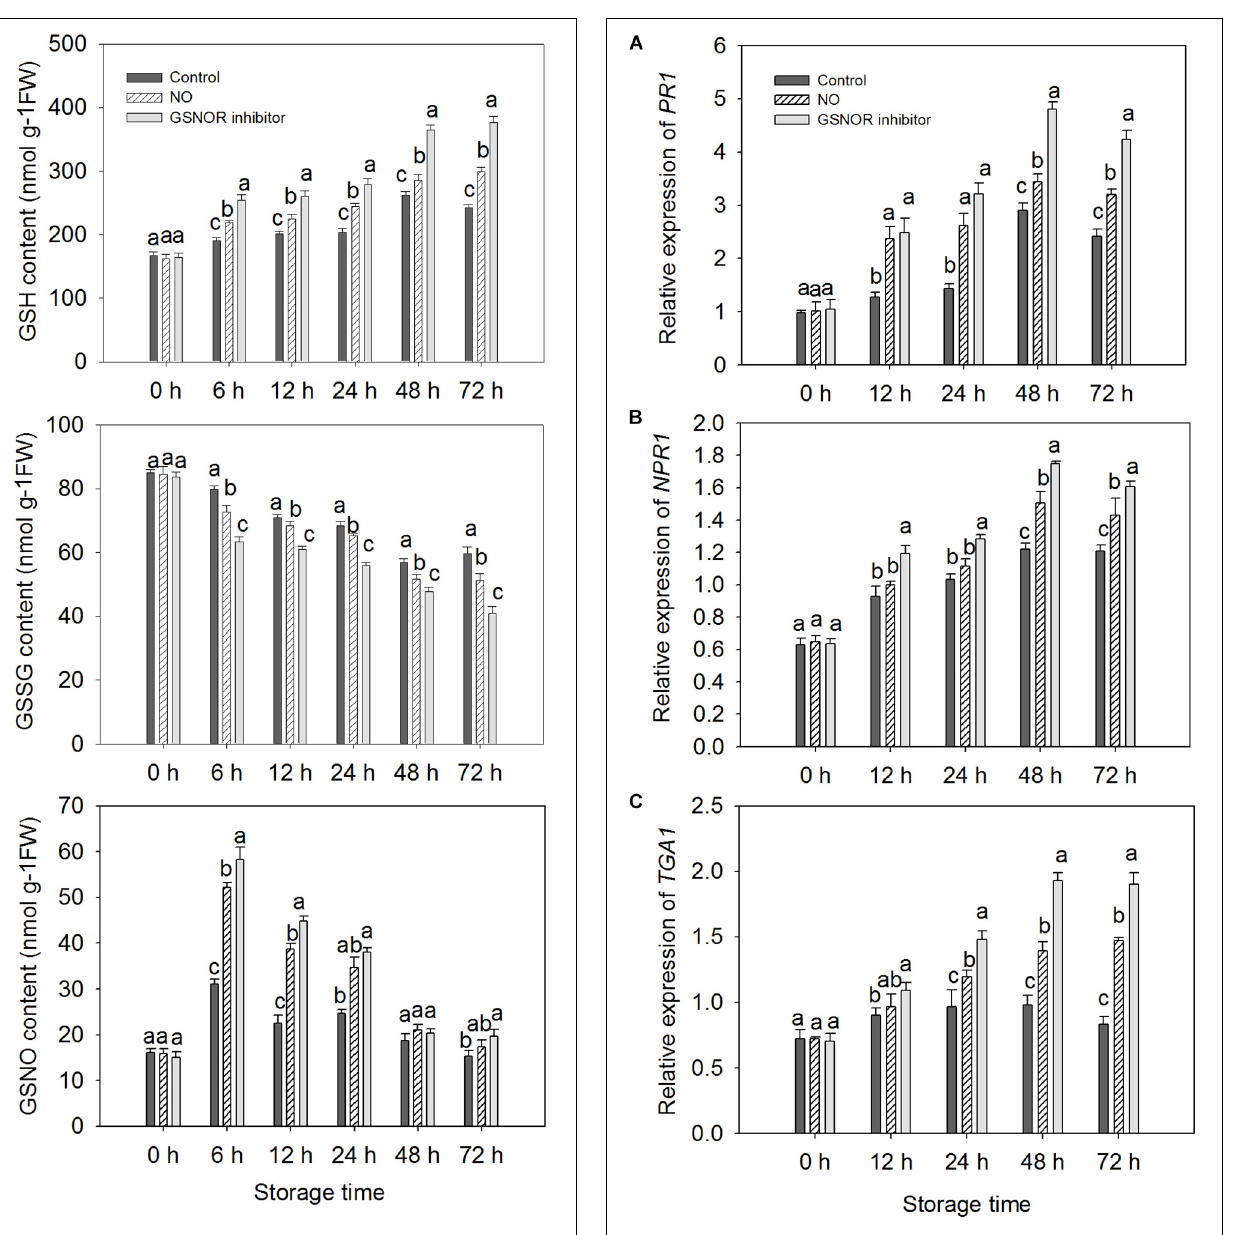
FIGURE 5 | Effect of nitric oxide (NO) or S -nitrosoglutathione reductase (GSNOR) inhibitor treatment on the level of (A) GSH, (B) GSSG, and (C) GSNO of peach fruit during storage at 23 ◦ C. Vertical bars represent the standard deviation of the means ( n = 6). Different letters represent significant differences ( P < 0.05) according to least significant difference (LSD) test.